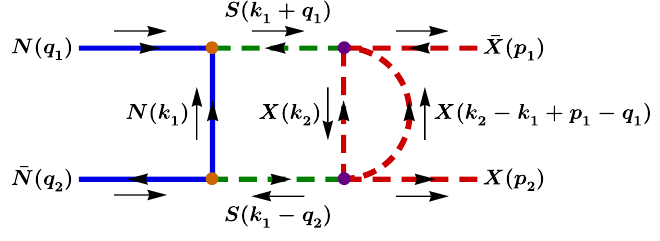
Figure 11 . The 4-momentum flows for the two-loop diagram of the 2 → 2 process N ¯ N → X ¯ X . after taking the average over initial and final spins, and including the symmetry factors for identical particles in the initial or final states, where for the second equalities we have used the Mandelstam variables for the 3 → 2 process, p of the initial particles at the nonrelativistic limit as